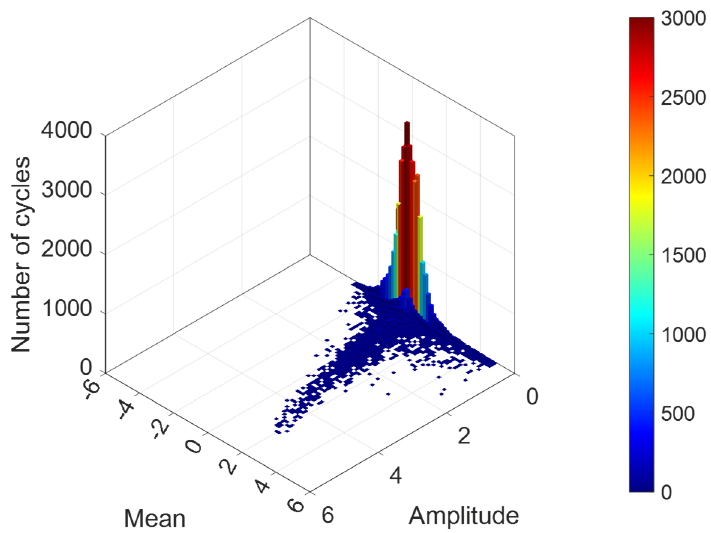
Figure 6. Three-dimensional histogram of rainflow matrix for the measured time history (CH6, outer rim), as a function of normalized amplitude and mean value of counted cycles. rim), as a function of normalized amplitude and mean value of counted